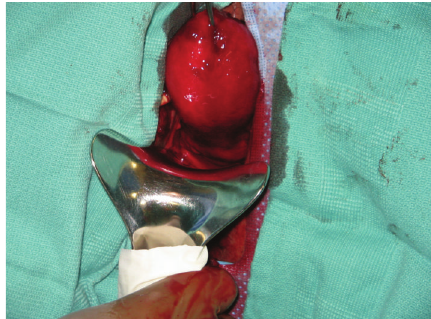
Figure 1: Uterine inversion.